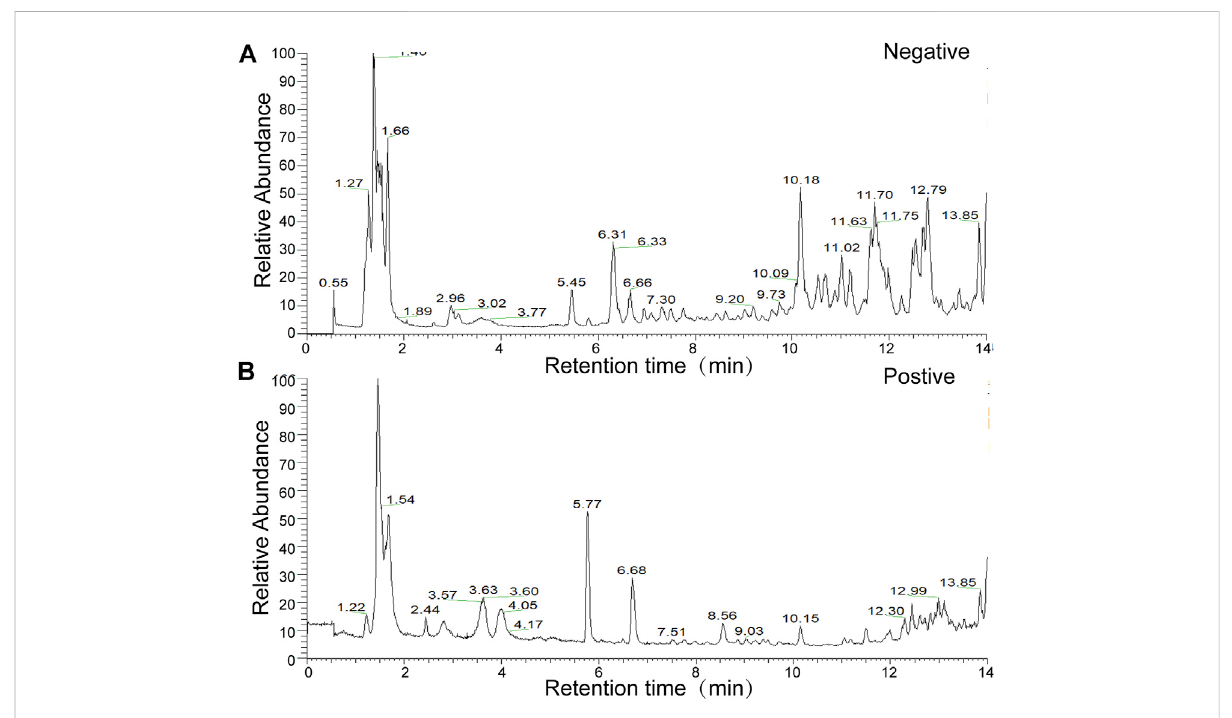
FIGURE 1 Total ion fl ow chart of sample in the (A) negative-ion mode (B) and in the positive-ion